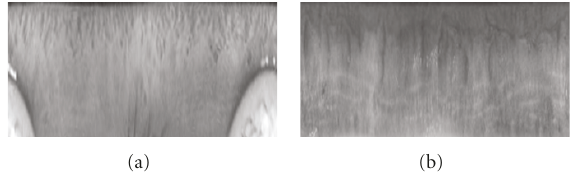
Figure 13: Examples of unwrapped images extracted from (a) ISEP and (b) CASIA